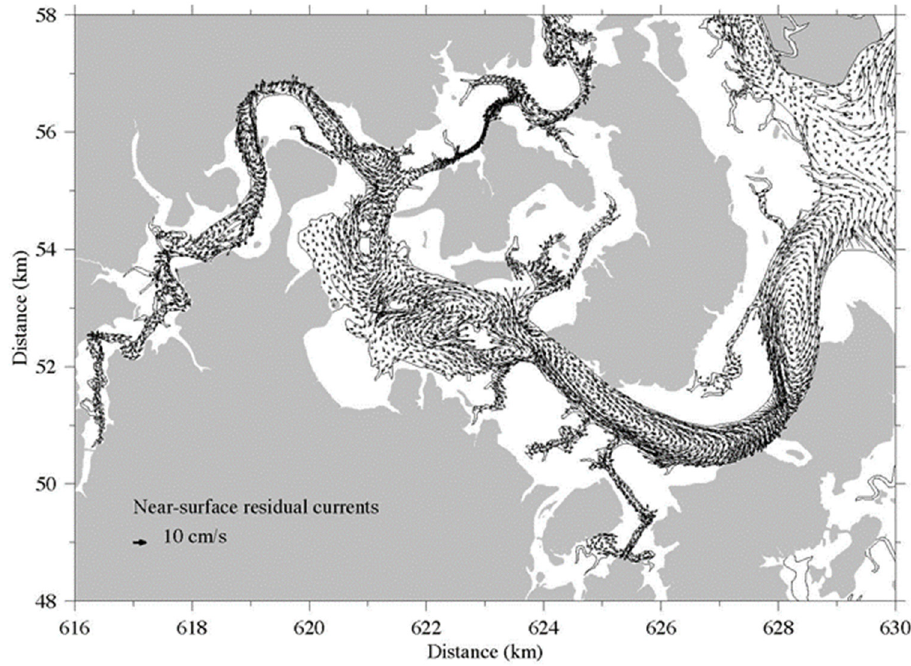
Figure 7. The distribution of FVCOM-predicted near-surface residual current vectors.